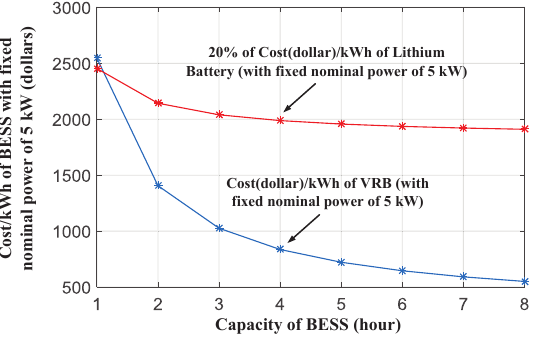
Figure 3. Cost(dollar)/kWh of VRB (blue) and lithium battery (red) with fixed nominal power (5 kW), but varying